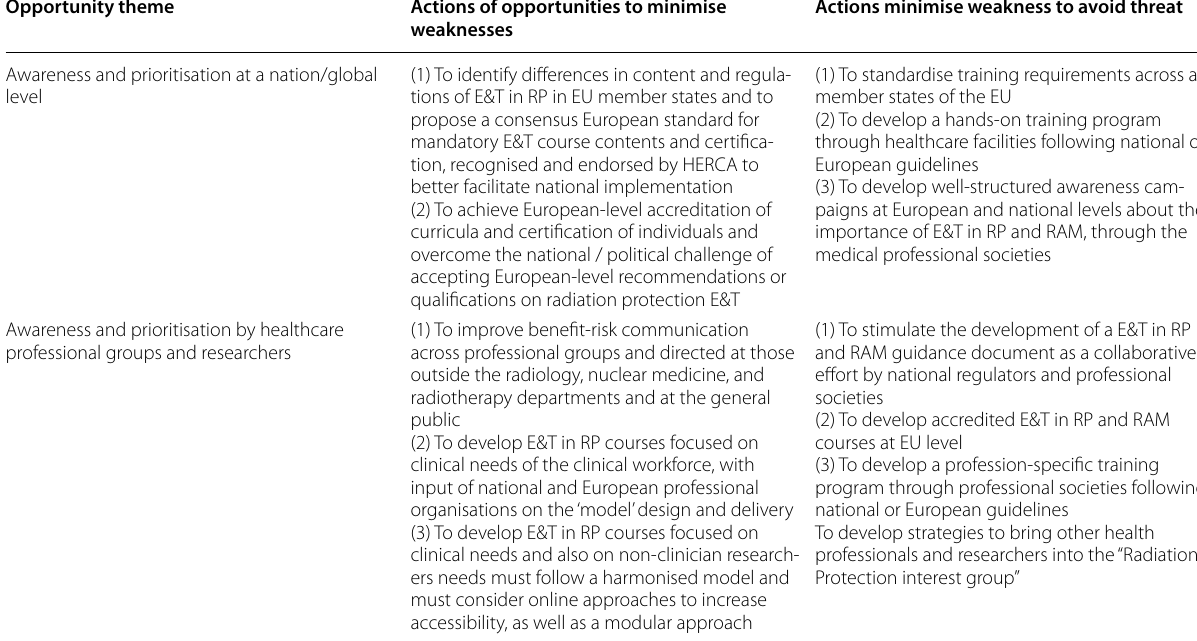
Table 4 Themed opportunities and actions to minimise weaknesses and to minimise weaknesses to avoid threats Opportunity theme Actions of opportunities to minimise Actions minimise weakness to avoid threat weaknesses Awareness and prioritisation at a nation/global